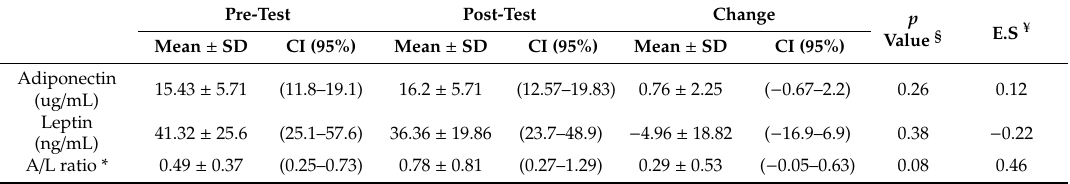
Table 4. Intragroup comparisons. Men (N =